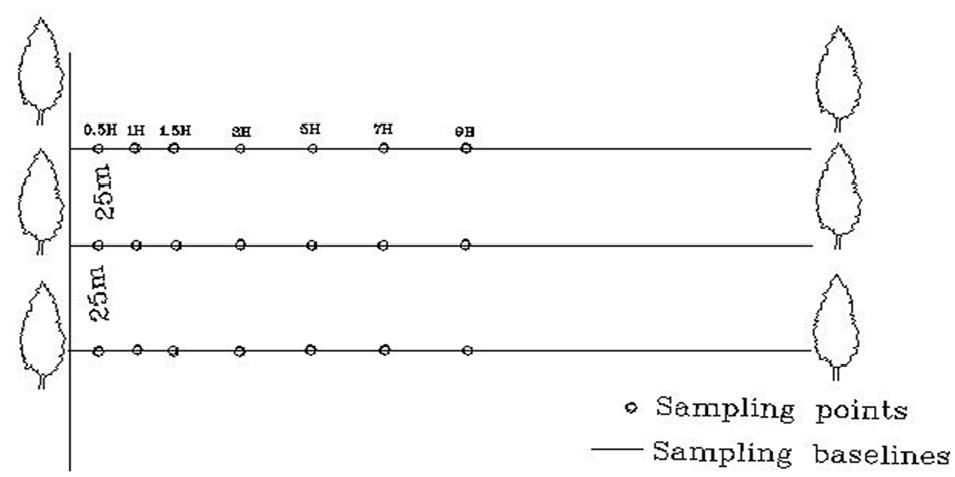
Figure 3. Sample point setup diagram.